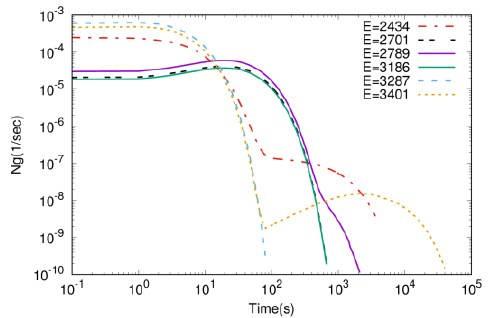
Fig. 6. The BDFG of n th + 241 Pu fission at variant energies as functions of the decay time.